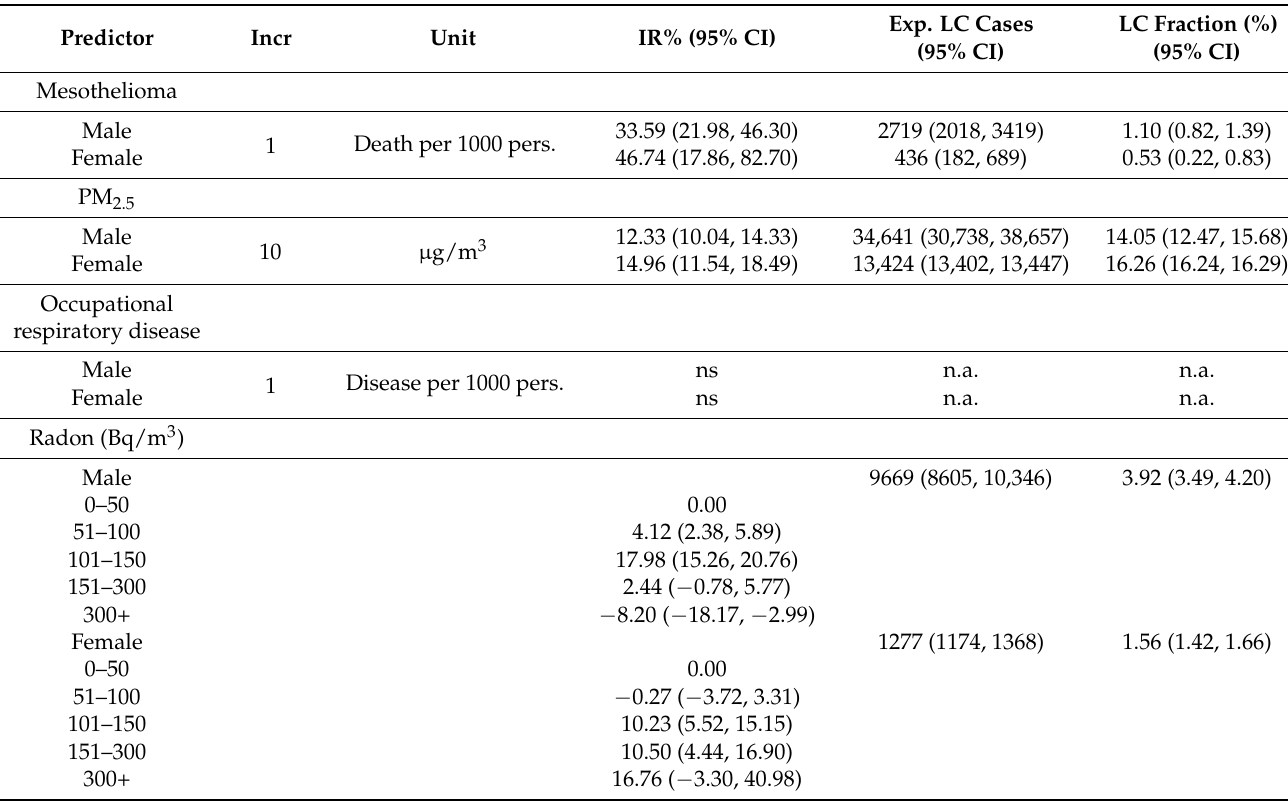
Table 4. Estimates of adjusted * Increment Risk (%) (approximate 95% CI) of lung cancer (LC) mortality, expected LC cases and attributable LC fraction by predictor,